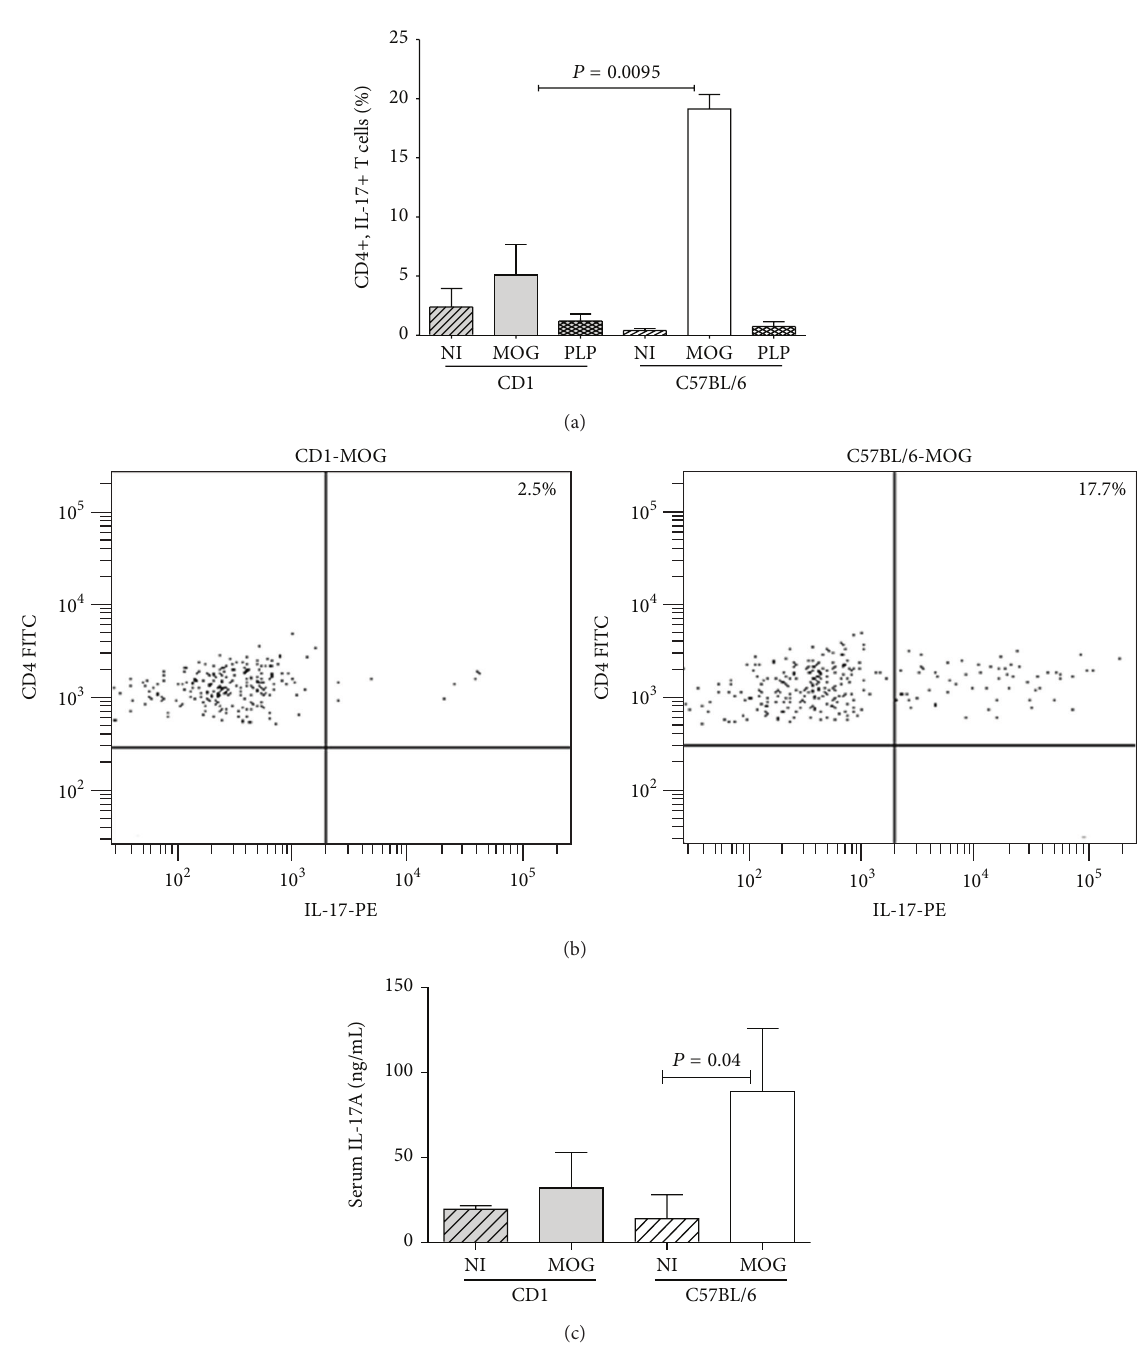
Figure 5: (a) Intracellular production of interleukin-17 (IL-17) by spleen CD4+ T cells. We analyzed these cells in series of seven mice per condition. Splenocytes from C57BL/6 and CD1 mice were cultured in presence of phorbol-12-myristate-13-acetate (PMA) and ionomycin during four hours and the percentage of CD4+ T cells showing intracellular production of IL-17 was analyzed by flow cytometry. We studied nonimmunized mice (NI) and mice immunized with MOG 35−55 (MOG) and with PLP 139−151 (PLP). Only C57BL/6 mice that developed EAE after immunization with MOG 35−55 displayed a significant increase in the percentage of CD4+ T cells producing IL-17. (b) Representative dot plots of IL-17 intracellular production by CD4+ T cells from MOG 35−55 -immunized CD1 and C57BL/6 mice are shown. (c) Serum concentrations of IL-17A in nonimmunized mice (NI) and mice immunized with MOG 35−55